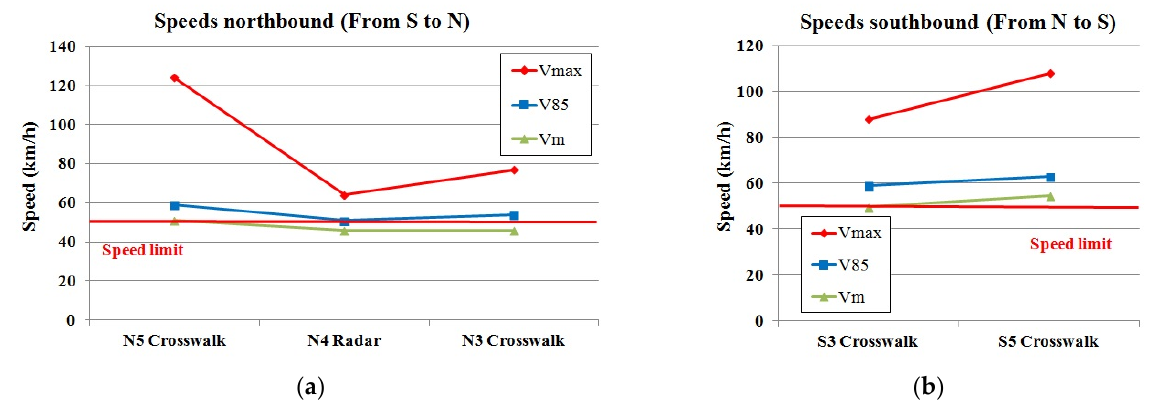
Figure 8. Speed at each controlled point in Arrankudiaga (Spain): ( a ) southbound, ( b ) northbound.